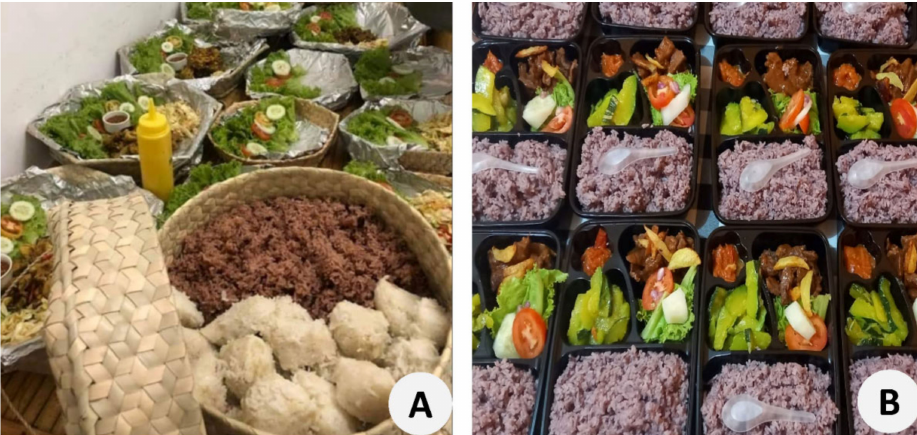
Figure 12. Traditional meals prepared with bean species cultivated in association with cashew agroforestry systems in East Timor: ( A ) Ceremonial meal with Vigna unguiculata (black) at the forefront; ( B ) traditional meal with rice, vegetables, and Vigna unguiculata from Baucau district (Photos L. Guterres and M.N.